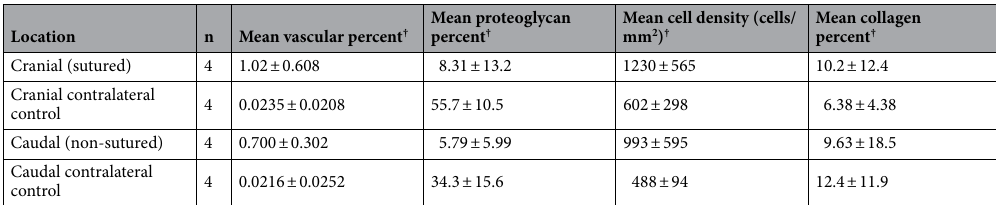
Table 1. Mean values of morphological features for sutured, non-sutured, and their respective contralateral control locations. Data represents both 6- and 10-week time periods as significant differences between these time periods were not observed. Values are reported with their Standard Deviation. † Values represent percentage of stain/immunostain positivity relative to the area of the section (or total area evaluated).